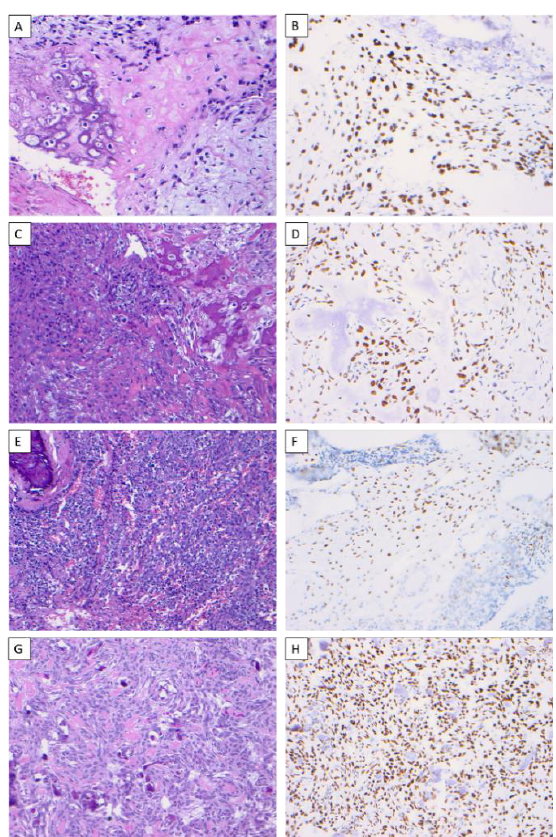
Figure 1. SATB2 expression in osteosarcoma. Chondroblastic osteosarcoma of the mandible (H & E) (×200) ( A ), chondroblastic osteosarcoma demonstrating nuclear immunoreactivity to SATB2 in a diffuse staining pattern with strong intensity ( × 200) ( B ), osteoblastic osteosarcoma of the maxilla (H & E) ( × 200) ( C